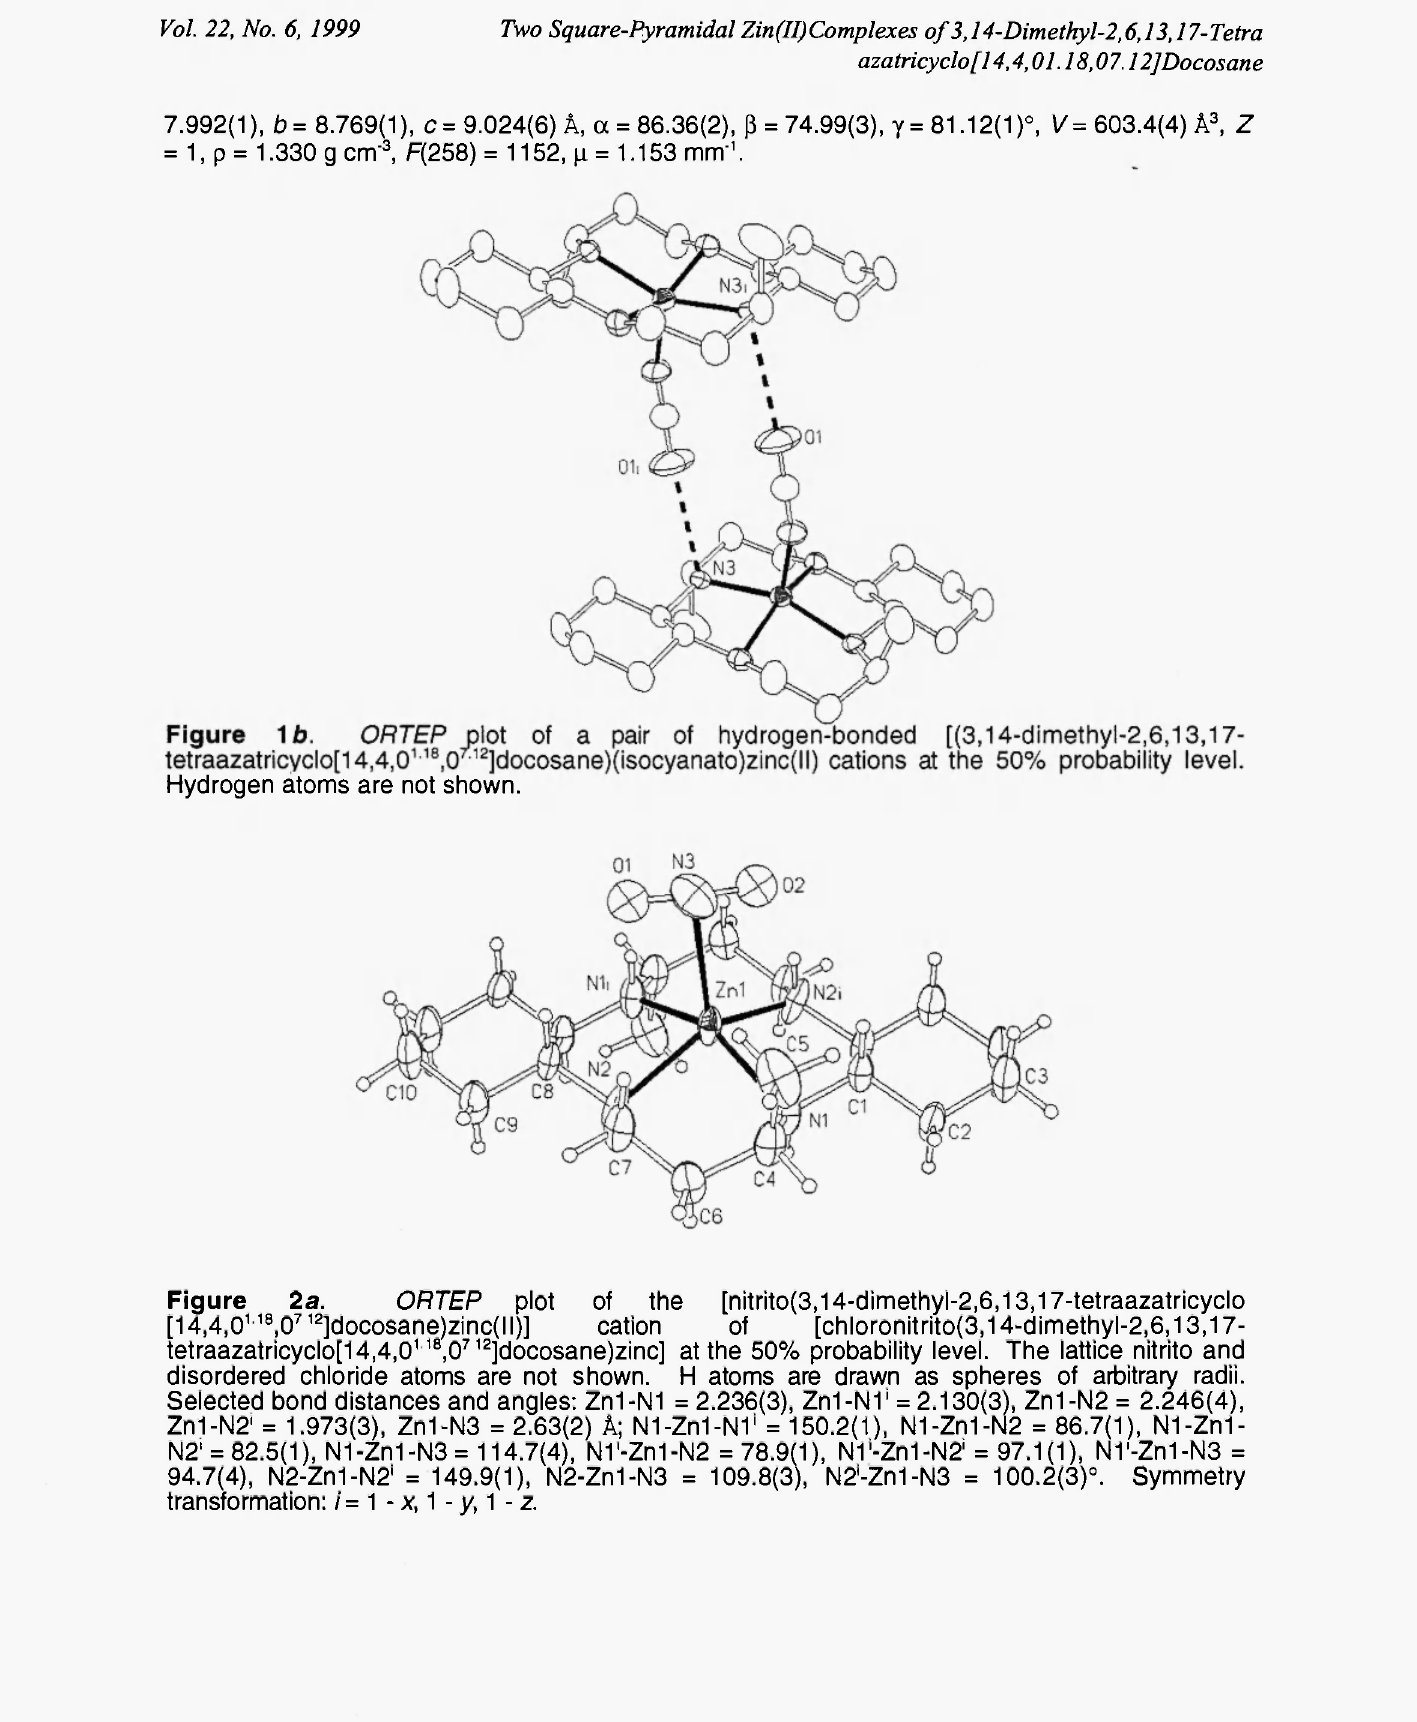
Figure 2a. ORTEP plot of the [nitrito(3,14-dimethyl-2,6,13,17-tetraazatricyclo [14,4,0 118 ,0 712 ]docosane)zinc(ll)] cation of [chloronitrito(3,14-dimethyl-2,6,13,17- tetraazatricyclo[14,4,0 1l8 ,0 712 ]docosane)zinc] at the 50% probability level. The lattice nitrito and disordered chloride atoms are not shown. Η atoms are drawn as spheres of arbitrary radii. Selected bond distances and angles: Zn1-N1 = 2.236(3), Zn1-N1' = 2.130(3), Zn1-N2 = 2.246(4), Zn1-N2' = 1.973(3), Zn1-N3 = 2.63(2) A; N1-Zn1-N1' = 150.2(1), N1-Zn1-N2 = 86.7(1), N1-Zn1- N2' = 82.5(1), N1-Zn1-N3 = 114.7(4), N1'-Zn1-N2 = 78.9(1), N1 i -Zn1-N2 i = 97.1(1), N1'-Zn1-N3 = 94.7(4), N2-Zn1-N2 i = 149.9(1), N2-Zn1-N3 = 109.8(3), N2 i -Zn1-N3 = 100.2(3)°. Symmetry transformation: /'= 1 - x, 1 - y, 1 -